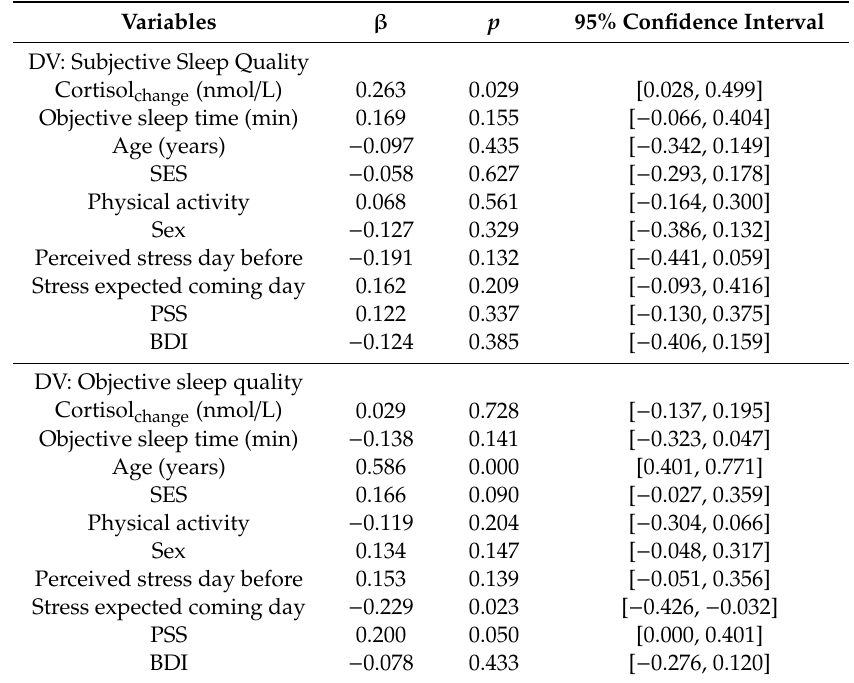
Table 2. Relationship between Cortisol change and subjective and objective sleep quality.